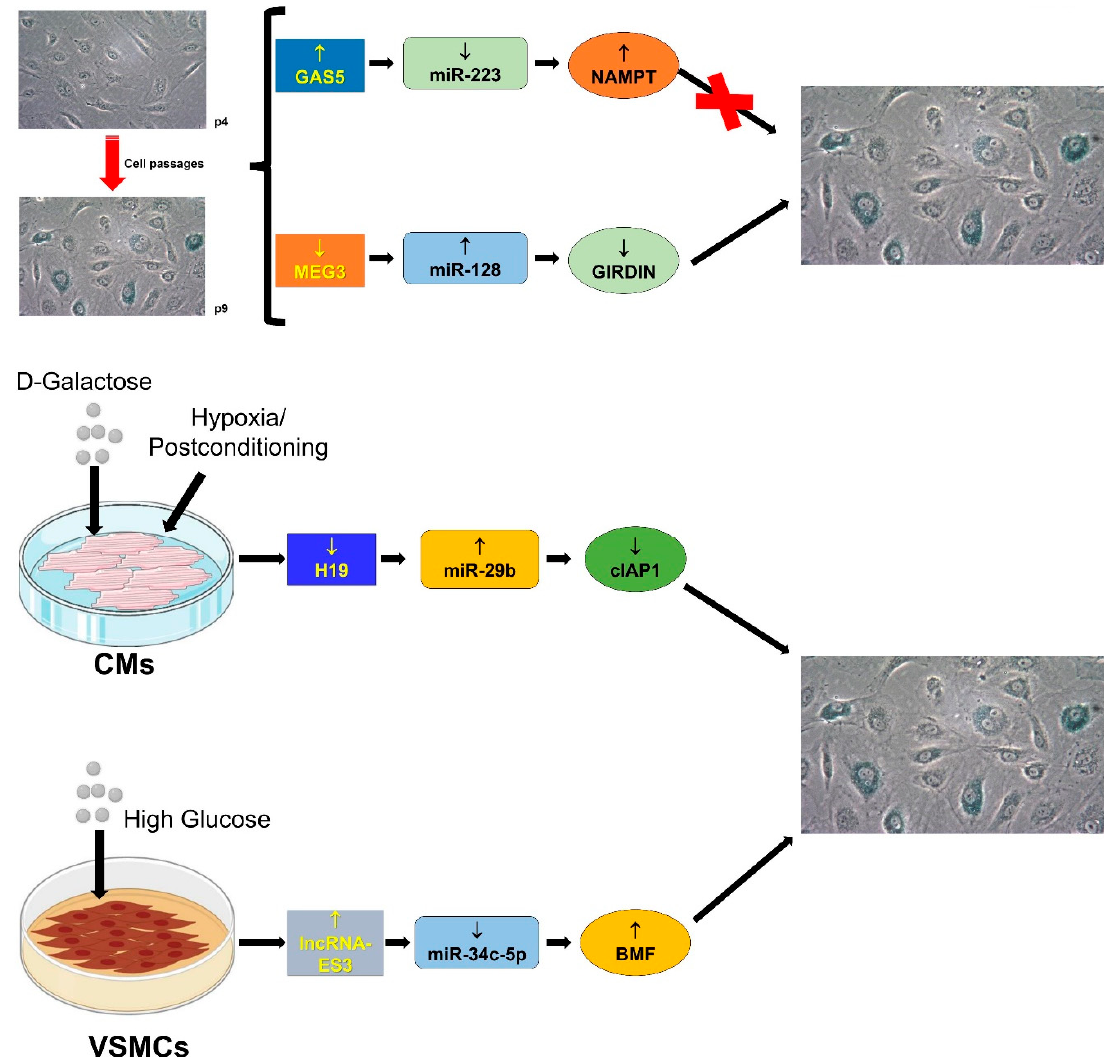
Figure 5. LncRNA-miRNA-mRNA networks and senescence. Cellular senescence is associated with the release of a large number of pro-inflammatory cytokines and growth factors. These factors cause an increased burden of tissue inflammation and oxidative stress that contribute to telomere shortening. Moreover, telomere shortening and cellular senescence are involved in aging and in the development of CVDs. The figure shows that the senescence phenotype can be induced by: (1) ageing the endothelial cells by culturing until late passages (p9) (2) stimulating cardiomyocytes (CMs) with D-galactose and (3) treating vascular smooth muscle cells (VSMCs) with high glucose. The lncRNA-miRNA-mRNA networks triggered by these conditions stimulate or inhibit senescence according to the modulated